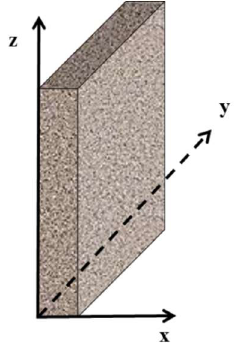
Figure 1. Reference system assigned to the specimens to conduct the analysis of the microstructure .